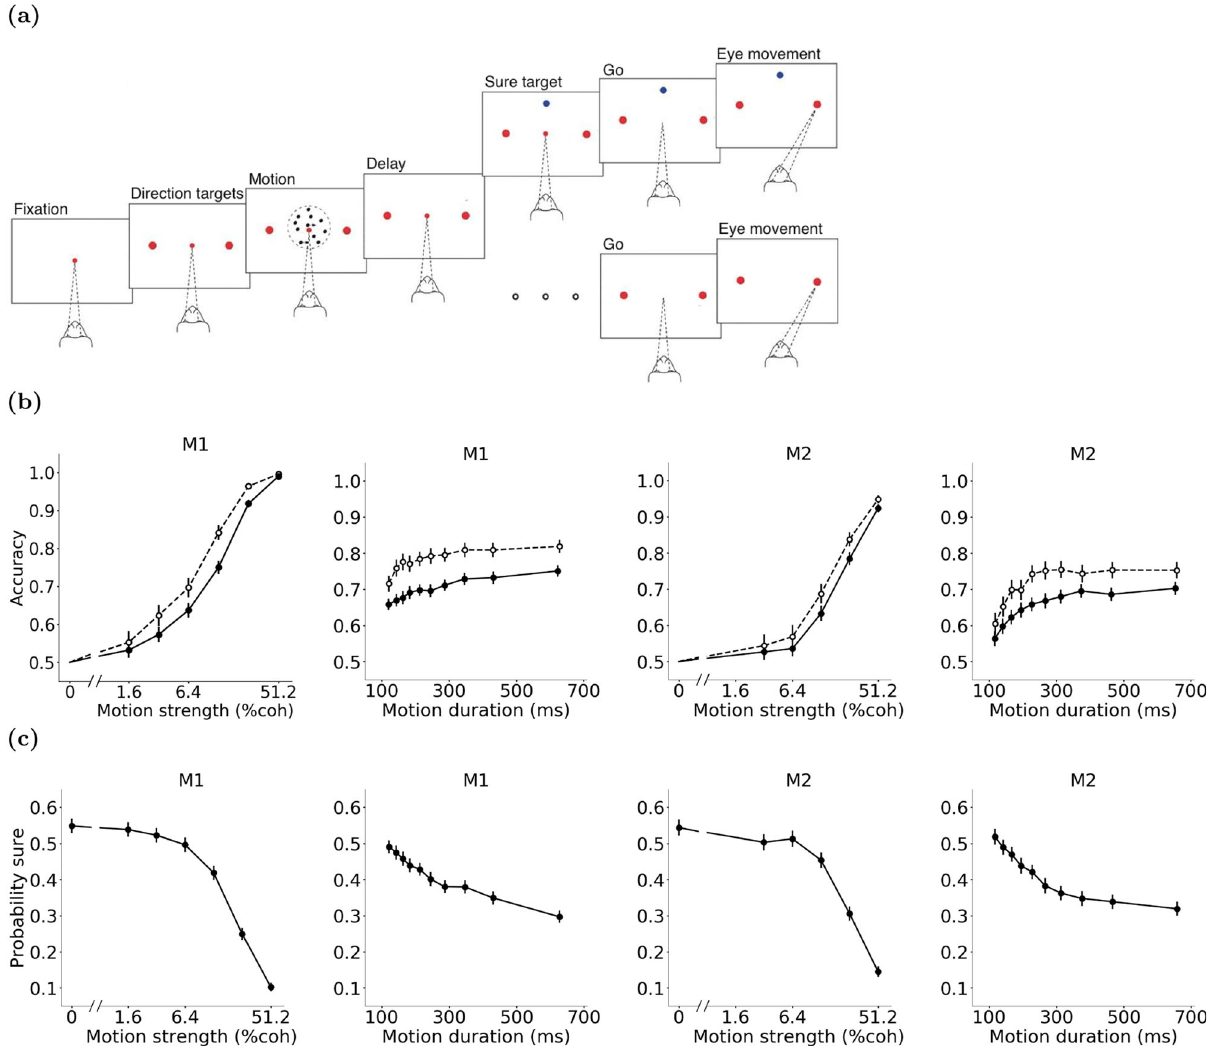
Fig. 1 Motion direction discrimination with post-decision wagering. a Task design. On each trial, monkeys viewed a patch of randomly moving dots and made a decision about the net direction of motion. Stimulus strength and duration varied randomly from trial to trial. On half of the trials, only the right and left direction targets were shown (large red dots). The motion stimulus was followed by a delay period. The central fi xation point (small red dot) disappeared at the end of the delay (Go cue), instructing the monkey to report perceived motion direction with a saccadic eye movement to one of the two direction targets. Choosing the correct target yielded a large reward, whereas choosing the incorrect target resulted in a short timeout. On the other half of the trials, a third target (sure target, shown as a blue dot) appeared on the screen during the delay period. Choosing this target after the Go cue yielded a guaranteed but smaller reward than choosing the correct direction target. b Accuracy as a function of motion strength and duration for the two monkeys (M1 and M2). For the motion strength plots, trials are pooled across all durations. For the motion duration plots, trials are pooled across all strengths. Solid lines show the accuracy on trials where the sure target was not presented (M1 motion strength plot: n = 6174 ± 112 per data point; M1 motion duration plot: n = 3720 per data point; M2 motion strength plot: n = 5035 ± 56 per data point; M2 motion duration plot: n = 2530 per data point). Dashed lines show the accuracy on trials where the sure target was shown but the monkey chose one of the high-stakes direction targets (M1 motion strength plot: n = 4148± 1314 per data point; M1 motion duration plot: n = 2261 per data point; M2 motion strength plot: n = 3376 ± 917 per data point; M2 motion duration plot: n = 1557 per data point). c Probability of choosing the sure target for different motion strengths and durations for monkeys M1 and M2 (M1 motion strength plot: n = 6195 ± 113 per data point; M1 motion duration plot: n = 4315 per data point; M2 motion strength plot: n = 5081 ± 79 per data point; M2 motion duration plot: n = 3031 per data point). Error bars indicate standard error of the mean action and observation: